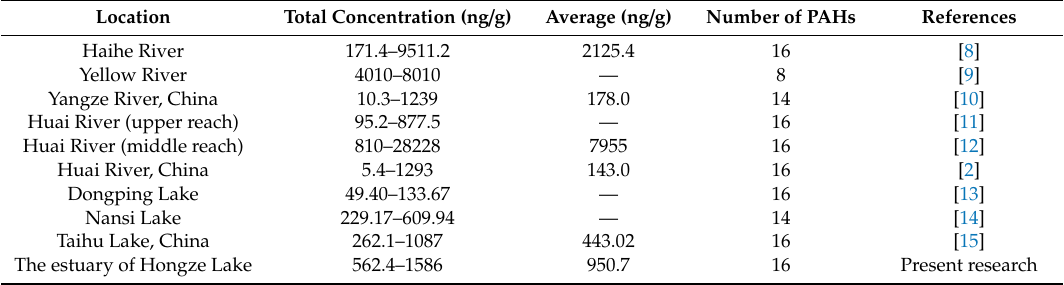
Table 1. Comparison of the content of PAHs in the estuary with worldwide research area.